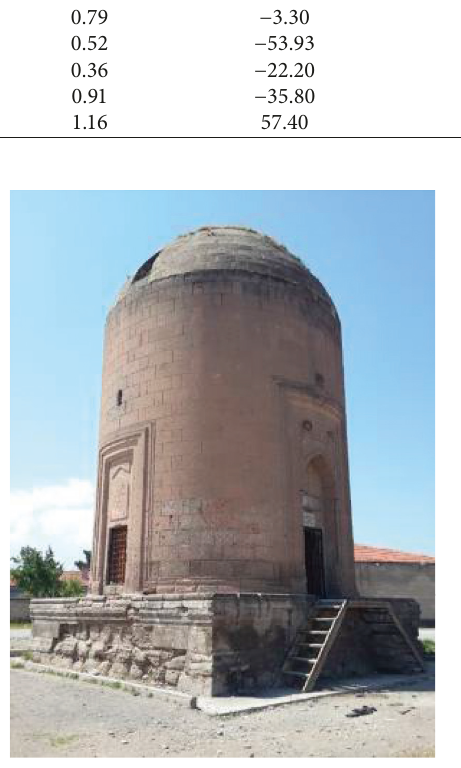
Figure 3: The Sircali